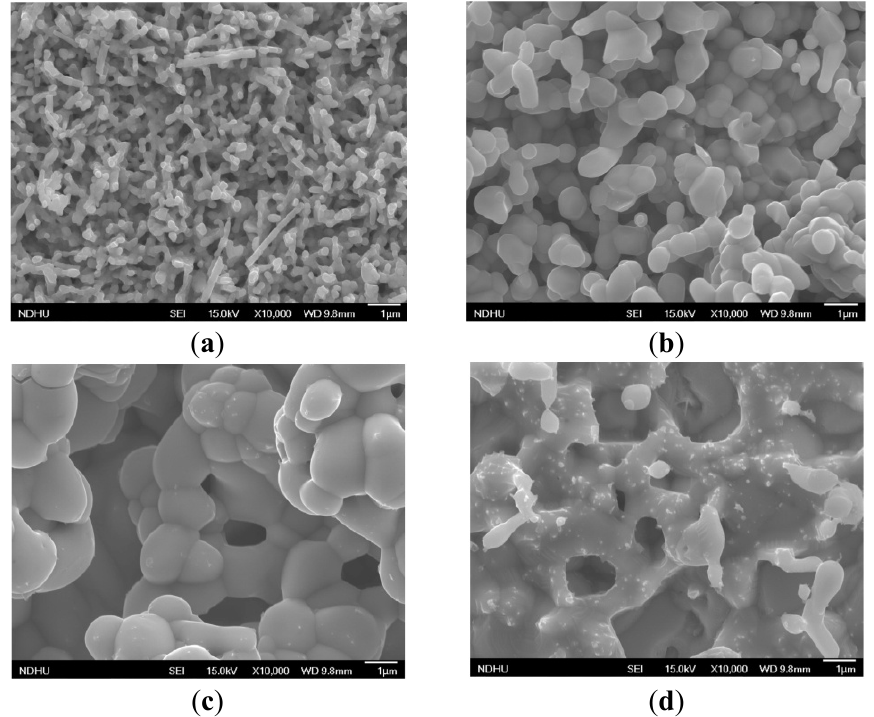
Figure 2. SEM images of the Cu 2 O counter electrodes sintered at ( a ) 400 °C, ( b ) 500 °C, ( c ) 600 °C, and ( d ) 700 °C.